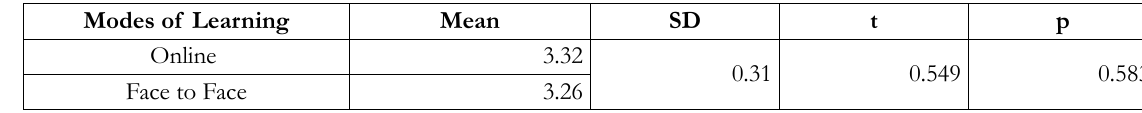
Table 4. Statistical Results of T-Test Analysis of Online Versus Face-To-Face Learning Modes